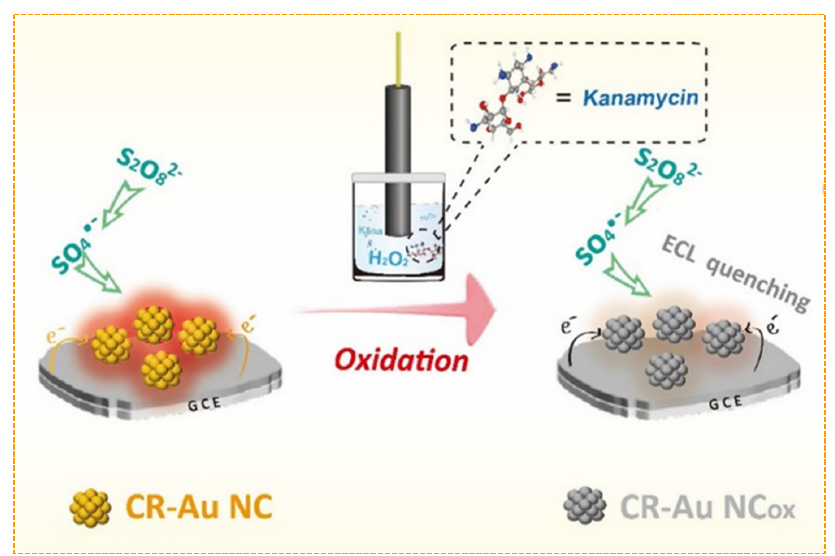
Figure 5. Scheme of the ECL sensor for kanamycin detection. Reproduced with permission from Ref. [73]. Copyright 2021, American Chemical Society.